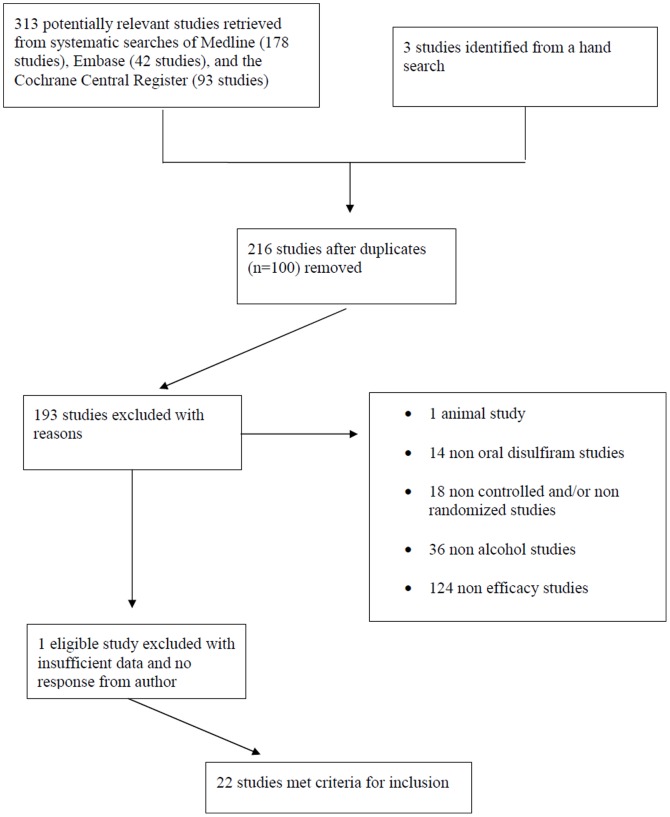
Flowchart of selection of studies for inclusion in the meta-analysis.